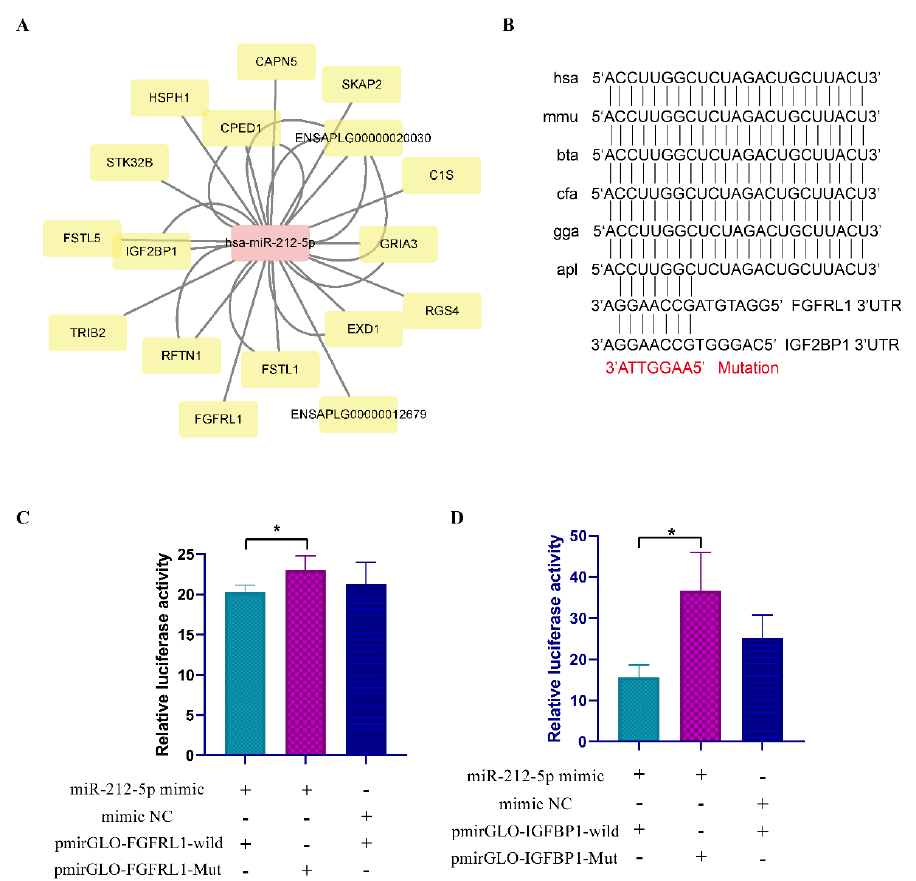
Figure 6. Dual-luciferase reporter assay validates the interaction between hsa-miR-212-5p and target genes. ( A ) has-miR-212-5p and its target genes (TargetScan and Miranda were used for the prediction. Target genes with context score percentile > 80 and max energy < − 18 were shown). ( B ) Interspecies conservation of miR-212-5p. The potential binding sites on FGFRL1 and IGF2BP1 are shown. The mutated sequence is shown in red. hsa, mmu, bta, cfa, gga, and apl represent Homo sapiens , Mus musculus , Bos taurus , Canis lupus familiaris , Gallus gallus , and Anas platyrhynchos . ( C , D ) Relative luminescence was measured and calculated after co-transfecting a wild type or mutant sequence of FGFRL1 and IGF2BP1 with miR-212-5p mimic (or mimic NC) in DF-1. In all panels, values are presented as mean ± SEM. * p <